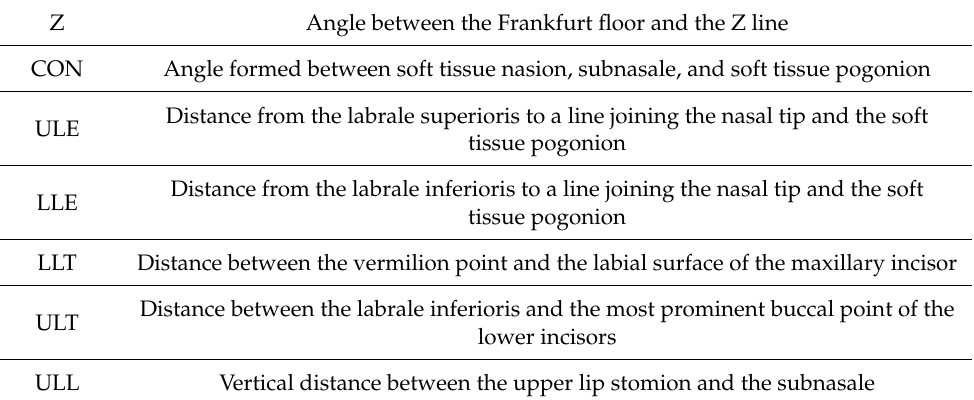
Table 2. Esthetic cephalometric variables. Z Angle between the Frankfurt floor and the Z line CON Angle formed between soft tissue nasion, subnasale, and soft tissue pogonion Distance from the labrale superioris to a line joining the nasal tip and the soft ULE tissue pogonion Distance from the labrale inferioris to a line joining the nasal tip and the soft LLE tissue pogonion LLT Distance between the vermilion point and the labial surface of the maxillary incisor Distance between the labrale inferioris and the most prominent buccal point of the ULT lower incisors ULL Vertical distance between the upper lip stomion and the subnasale